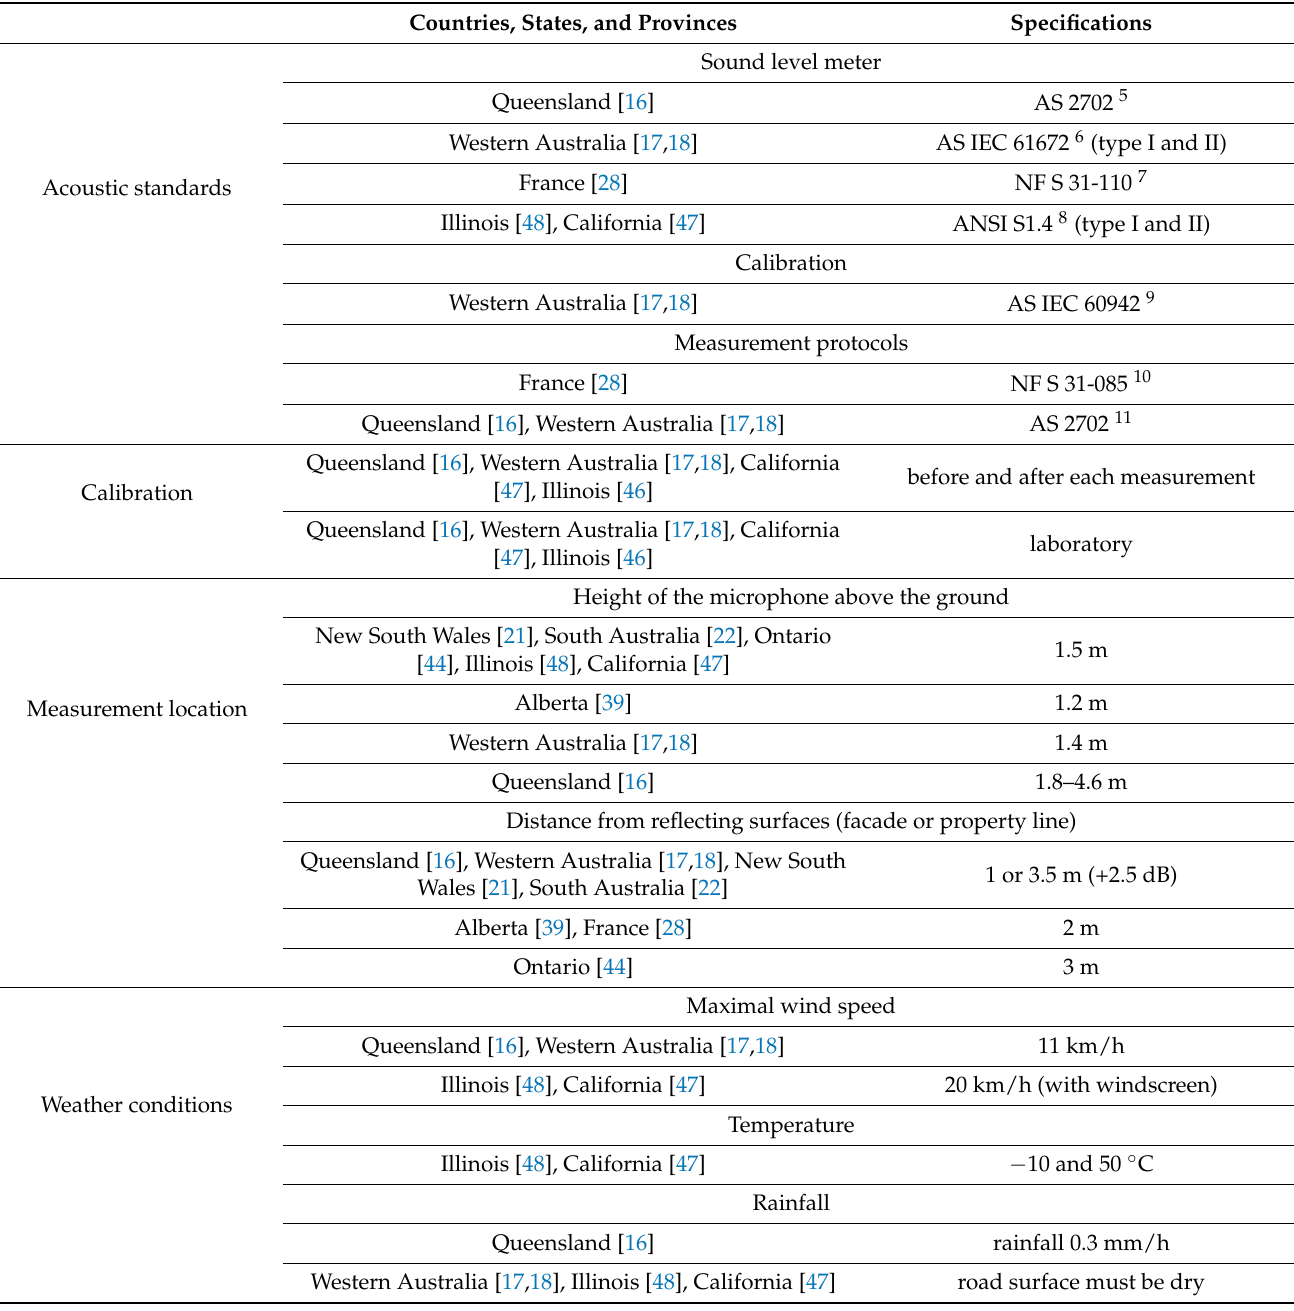
Table 8. Specifications of the measurement protocols in noise policies. Countries, States, and